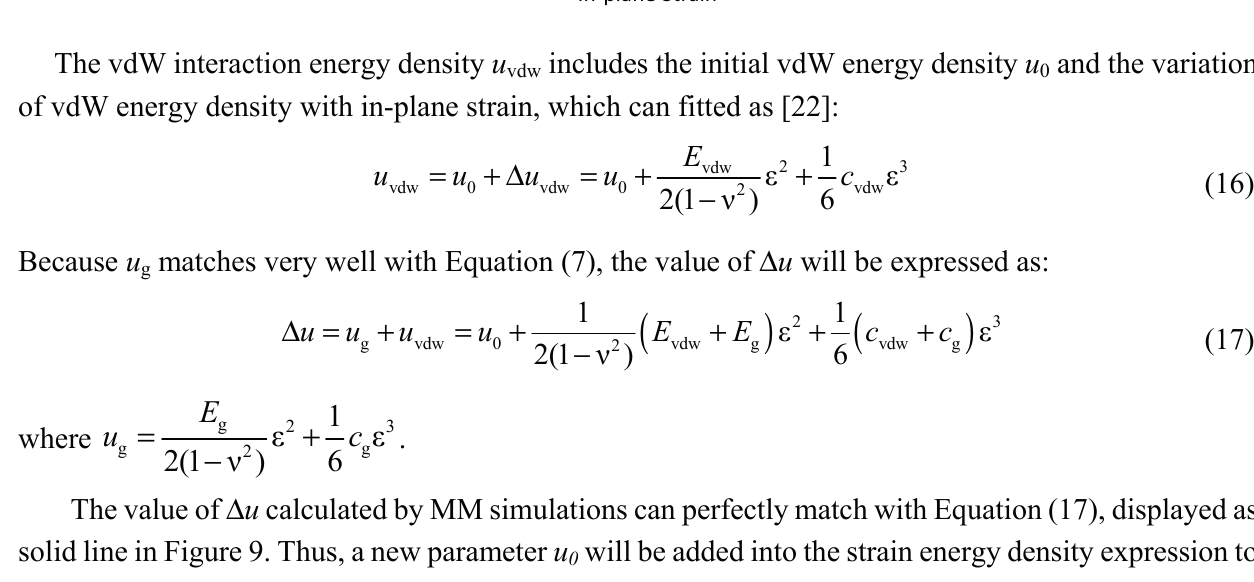
Figure 9. MM simulation result of the strain energy density Δ u of monolayer graphene under free standing indentation and its components u u (the van der Waals (vdW) interaction energy between indenter tip and graphene), vdw varying with in-plane strain. The right side is for the ratio of u